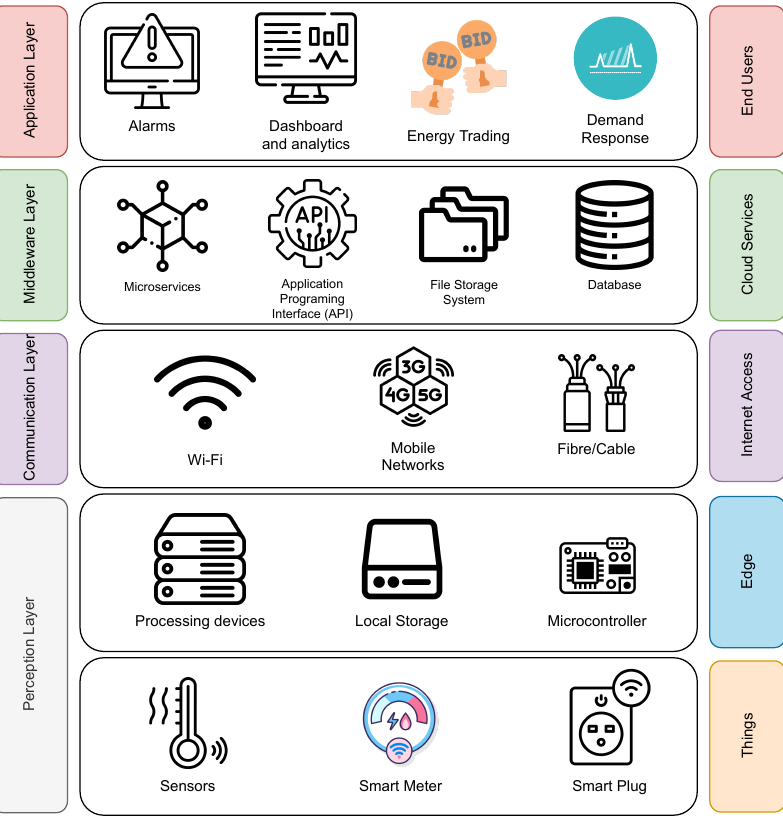
Figure 1. Cloud-IoT HEMS